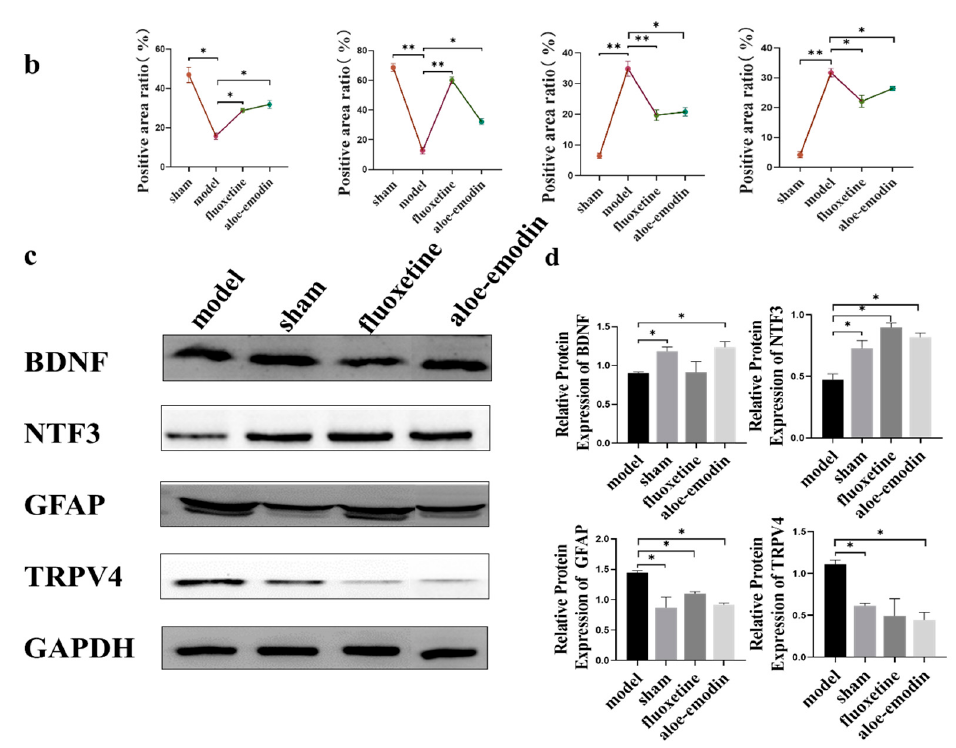
Figure 4. ( a ) Immunohistochemical detection of the expressions of BDNF, NTF3, GFAP, and TRPV4 in brain tissue; ( b ) quantitative analysis of immunohistochemical staining (n = 3); ( c ) Western blot detection of BDNF, NTF3, GFAP, and TRPV4 protein expressions in brain tissue; and ( d ) quantitative analysis of Western blot detection of BDNF, NTF3, GFAP, and TRPV4 protein expressions in brain tissue (n = 3). (** p < 0.01) (* p < 0.05).